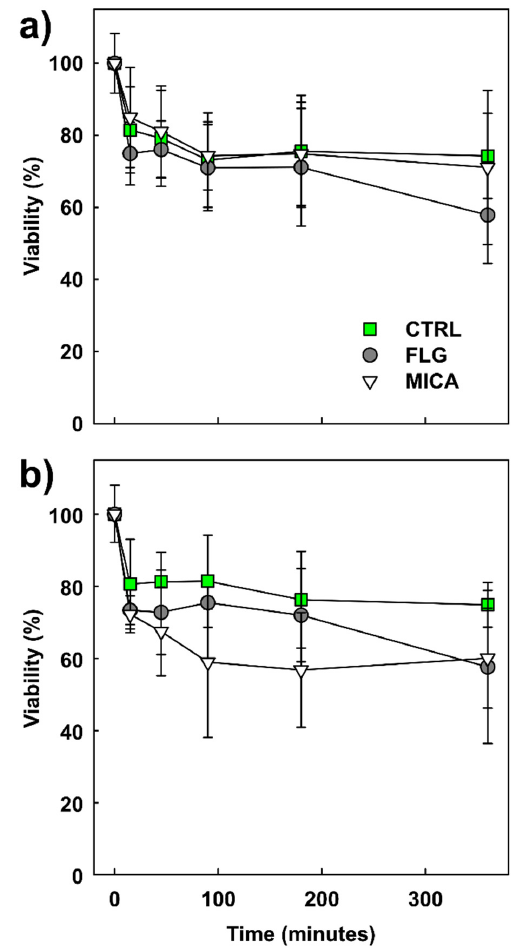
Figure 1. ( a ) Viability of Cucurbita pepo L. pollen in untreated (CTRL) and few-layer graphene (FLG)- or muscovite mica (MICA)-treated samples during six hours’ incubation at 2 mg of nanomaterials (NMs) per g of pollen; ( b ) the same at 0.5 mg of NMs per g of pollen. Pollen viability is expressed as a percentage of the viability of freshly harvested pollen ( n = 200). Values are means ± s.d. ( n = 3–4).